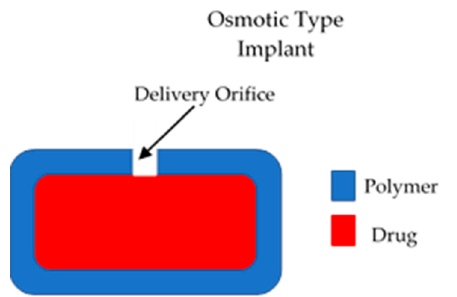
Figure 2. An illustration of an osmotic implantable drug delivery systems.